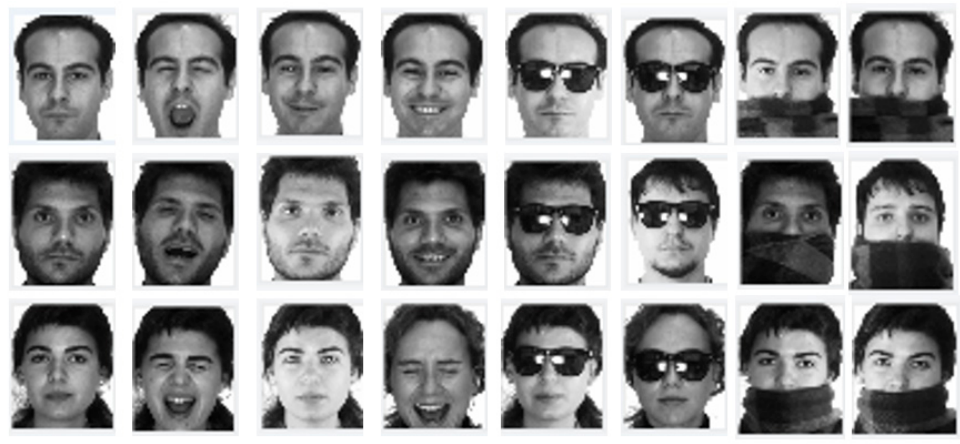
Figure 4. Some samples of the AR database.